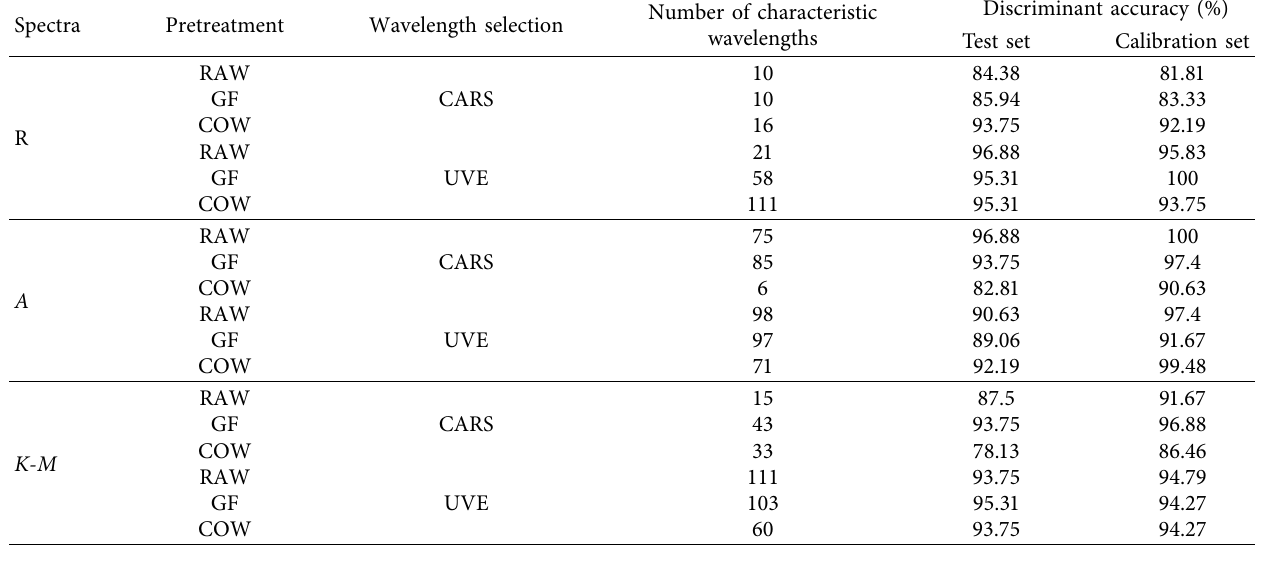
Table 4: Discriminant results of SVM based on the characteristic wavelengths of R , A, and K - M spectra. Spectra